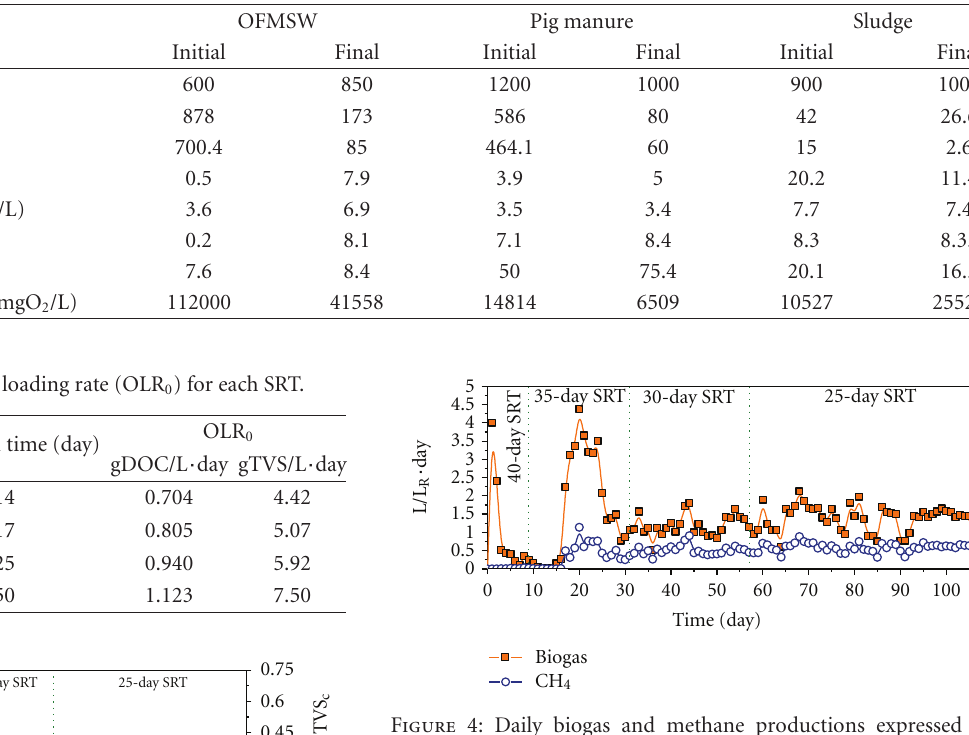
Table 3: Initial and final compositions of the wastes.